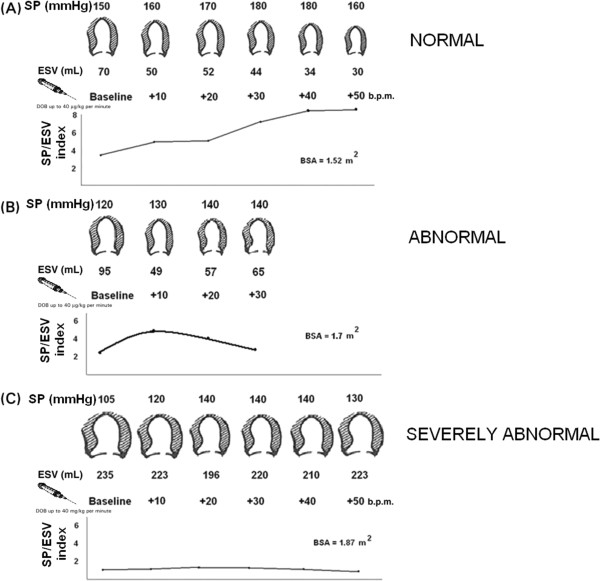
Methodology of the force-frequency relation with stress echo. Left, from upper to lower rows: systolic blood pressure (SP) by cuff sphygmomanometer (first row); LV end-systolic volumes (ESV) calculated with the biplane Simpson method (second row); heart rate increase (b.p.m.) during dobutamine infusion (third row); in the lowest row, the force-frequency relation built off-line with the values recorded at baseline (second column), and at different steps (third, fourth, fifth columns) up to peak exercise (seventh column). (A) Normal subject. An increased heart rate is accompanied by an increased systolic pressure with smaller end-systolic volumes (normal up-sloping PVR). (B) A subject with LV dysfunction (EF% = 32%) without dilation, no stress-induced ischemia. The PVR was biphasic, with an initial up-sloping followed by a later down-sloping trend, the critical heart rate (90 b.p.m.) was the heart rate beyond which SP/ESV index declined by 5%. The test was stopped at 20 gammas due to limiting symptoms (dyspnea). (C) A subject with post-MI depressed baseline LV function (EF% = 30%). An increased heart rate at peak exercise is accompanied by no changes in end-systolic volumes (abnormal flat PVR). (Modified from Grosu A, EHJ 2005). BSA = Body surface area; ESV = End-systolic volume; PVR = Pressure-volume relation; SP = Systolic pressure; SP/ESV = Systolic pressure/end-systolic volume ratio.